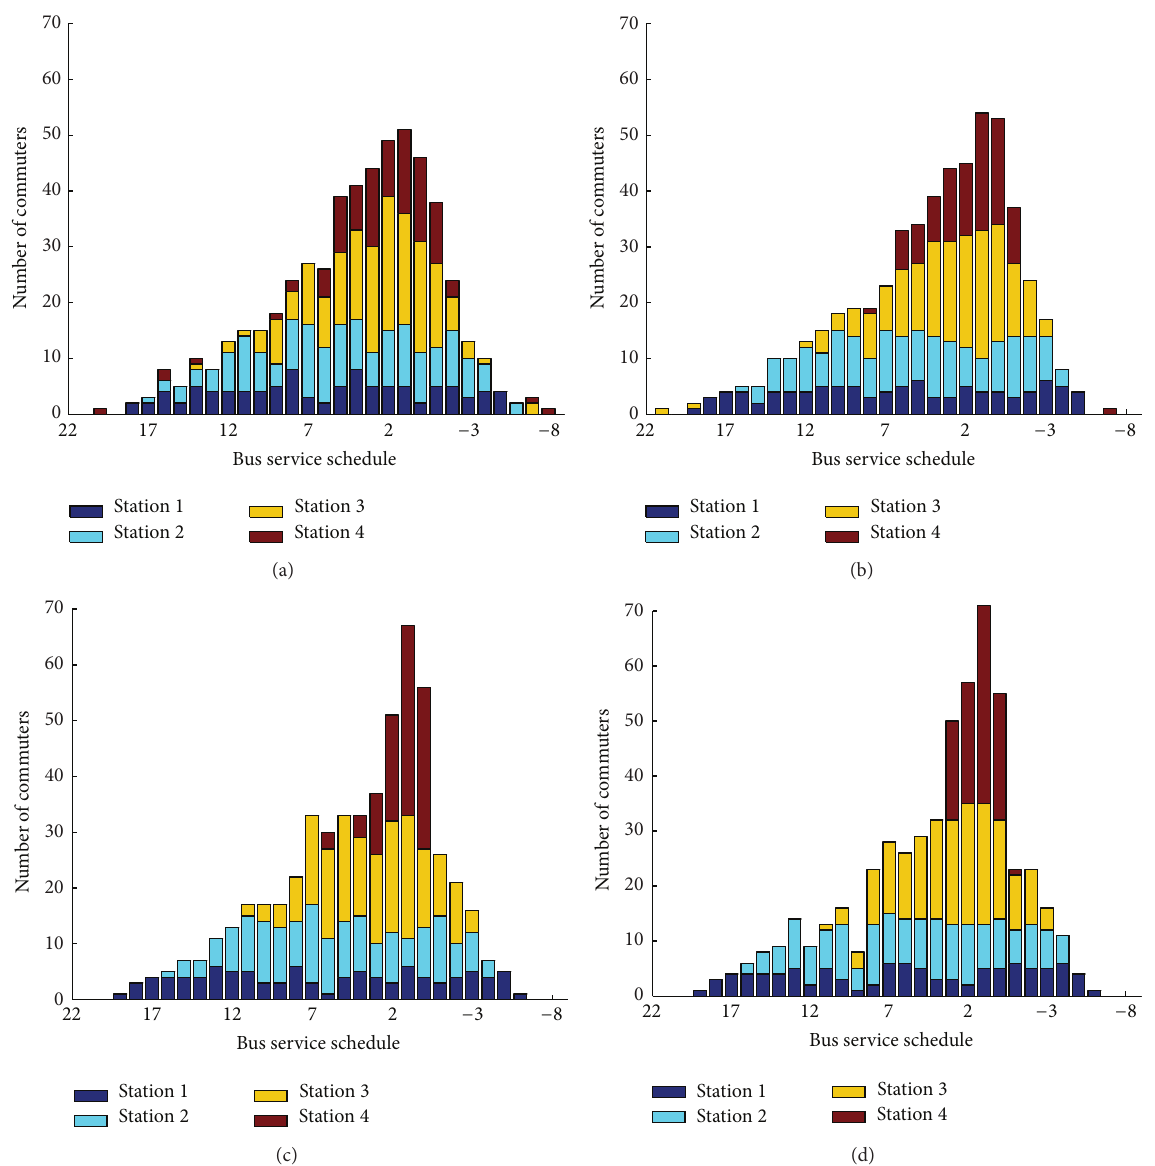
Figure 16: Snapshots of commuters’ distribution in the long-term memory experiment. ((a) Day 500, (b) day 1000, (c) day 2000, and (d) day